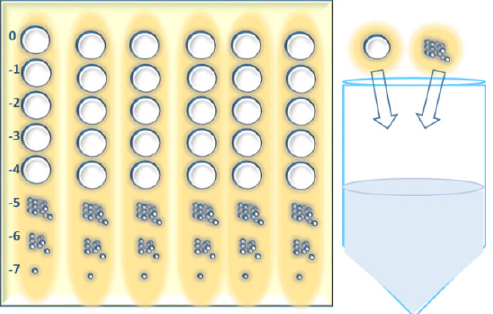
Figure A6. Diagram depicting the “Host Range Expansion (HRE) on agar” method.